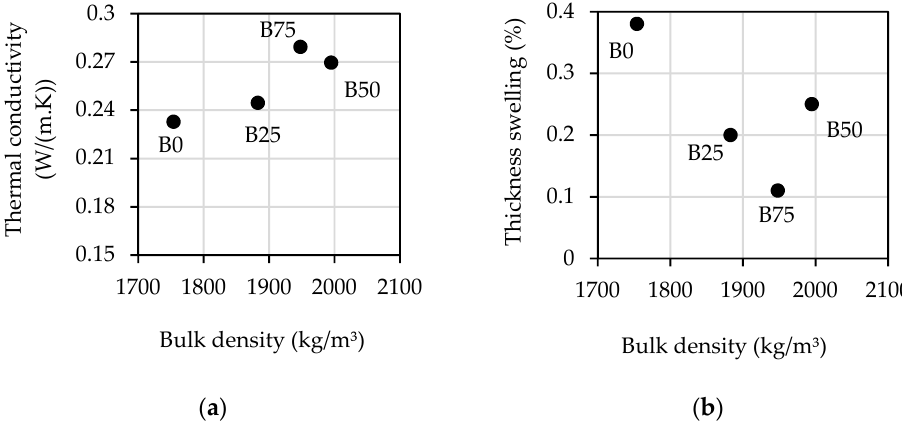
Figure 6. Comparison: ( a ) between bulk density and thermal conductivity; ( b ) between bulk density and thickness swelling.